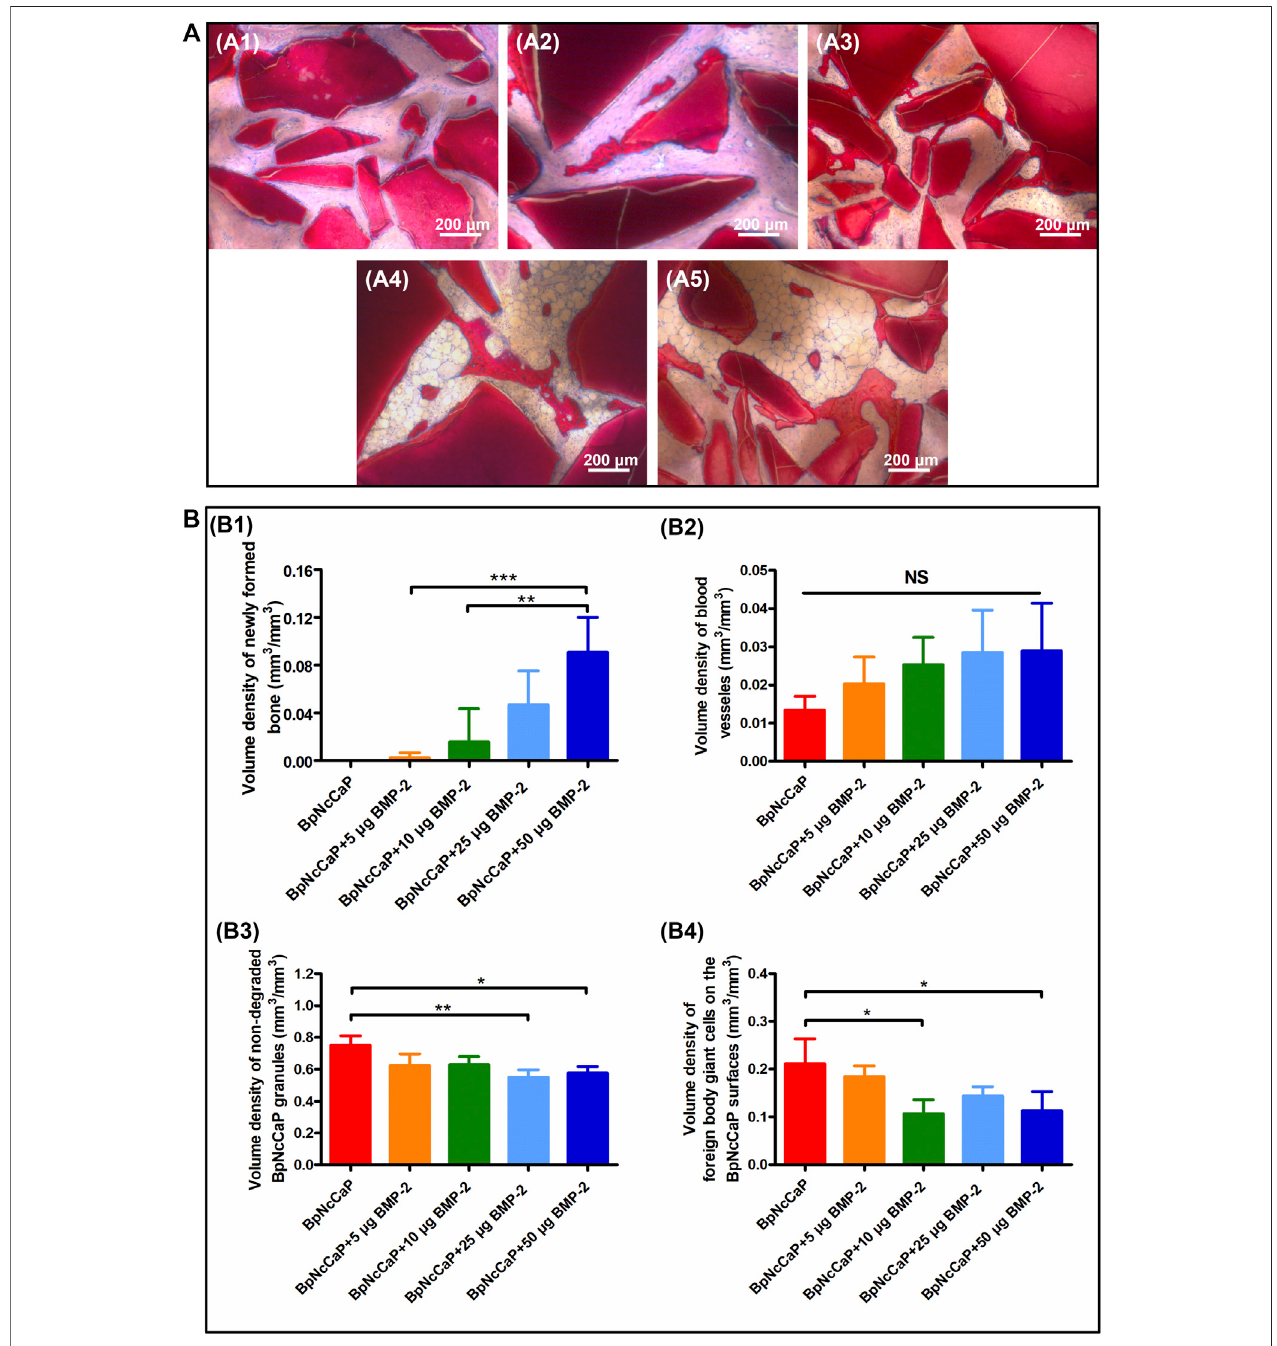
FIGURE 8 | Light micrographs (A) of newly formed bone and remaining BpNcCaP without (A1) or with different amount (5/10/25/50 μ g) of BMP-2 (A2-A5) 5 weeks after implantation. Graphs (B) depicting the volume densities ofnewly formed bone (B1) ,blood vessels (B2) , undegraded particles (B3) and foreign body giant cells (B4) on the surfaces of BpNcCaP and 5/10/25/50 μ g BMP-2 incorporated BpNcCaP granules. The sections were surface-stained with McNeal ’ s Tetrachrome, basicFuchsineandToluidineBlueO. Meanvalues( n =6) wererepresented togetherwiththestandarddeviation,signi fi canteffect ofthetreatment:* p < 0.05; ** p < 0.01; *** p <